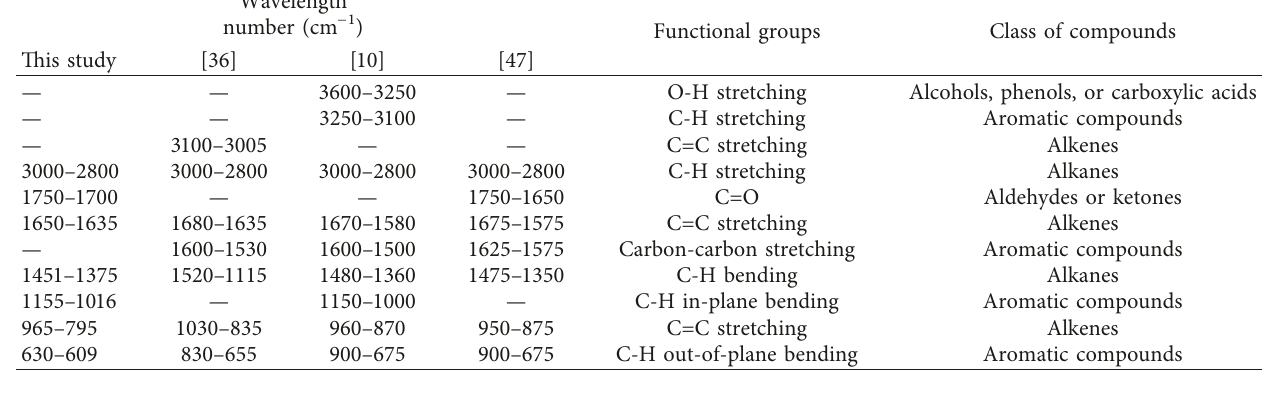
Table 5: FTIR functional groups and the indicated compounds of this study pyrolytic oil with other pyrolysis liquids. Wavelength number (cm − 1 ) Functional groups Class of